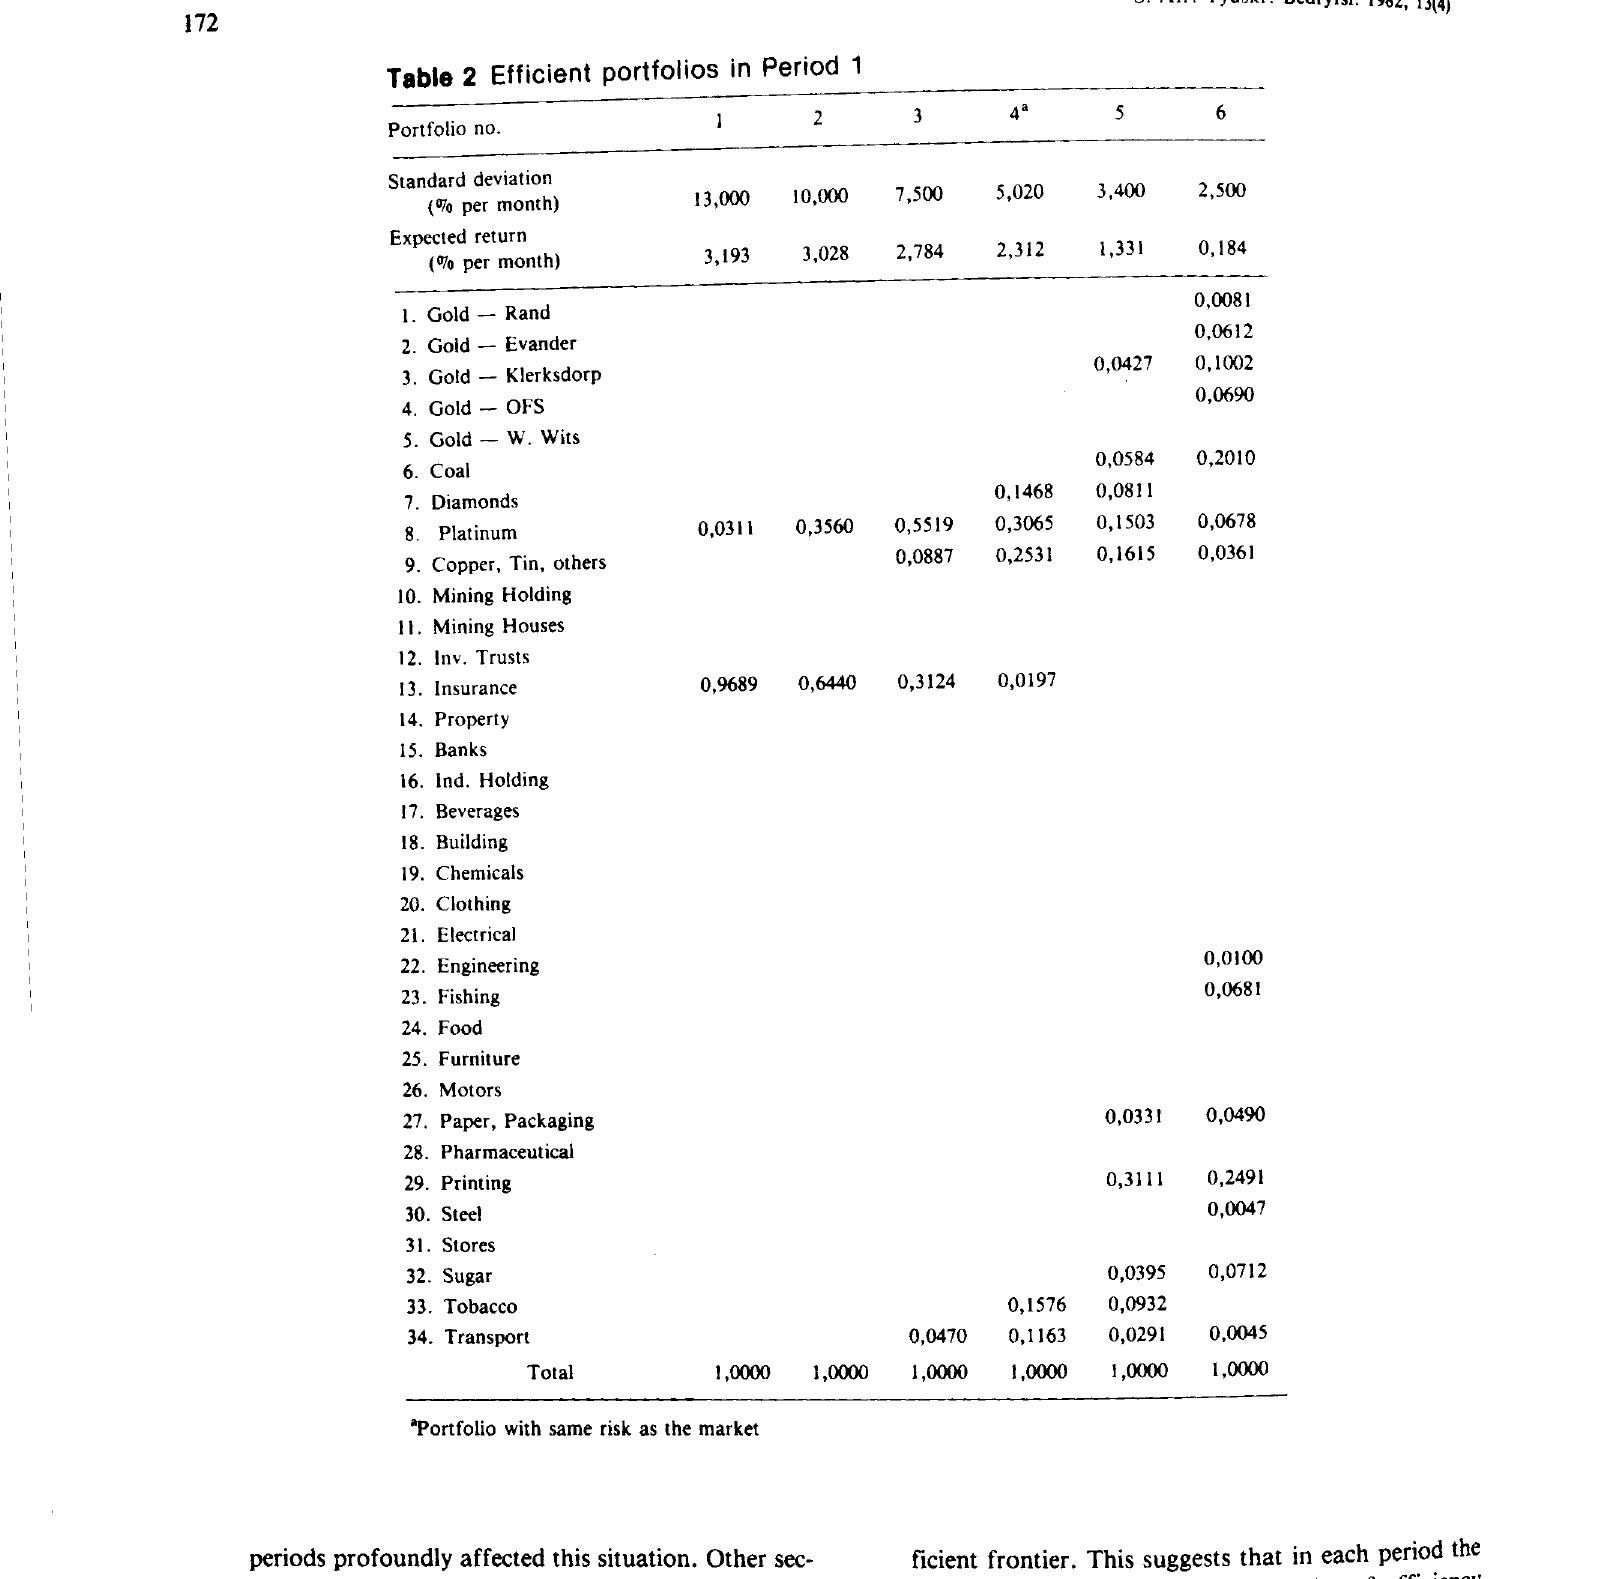
Table 2 Efficient portfolios in Period 1 Portfolio